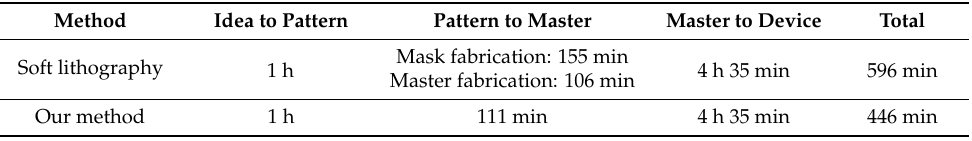
Table 4. The comparison in fabrication time between soft lithography and our